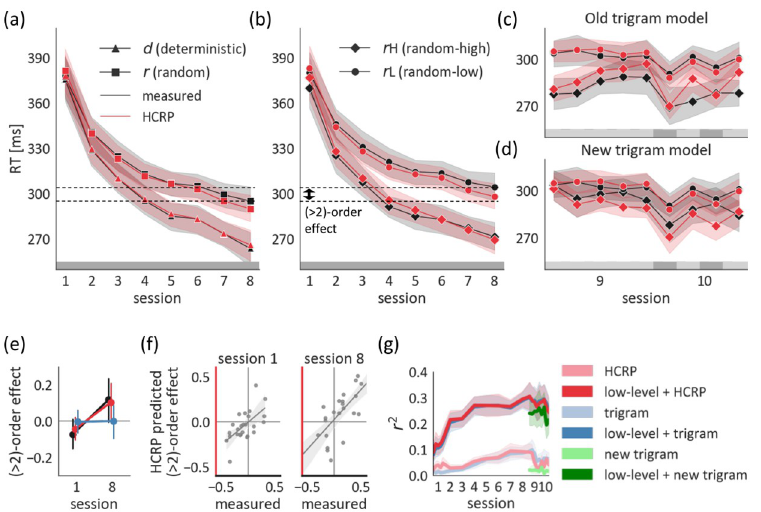
Fig 7. Calibration of the HCRP model. (a) RTs predicted by our HCRP model are shown against measured RTs for d versus r trials on held-out test data. (b) Same as (a) for r H versus r L trials. The two dashed lines mark the mean RTs for d and r H trials in session 8. The RT advantage of d over r H by session 8 marks ( > 2)-order sequence learning. (c-d) r H versus r L trials are labelled according to the old trigram model (i.e. old sequence) or the new trigram model (i.e. new sequence). The grey band on the bottom shows the sequence that participants practiced: the old sequence in sessions 1–8 (dark grey), the new sequence in session 9 (light grey) and alternating the two sequences in session 10. (e) ( > 2)- order sequence learning, quantified as the standardized RT difference between r H and d trials, shown for measured and predicted RTs. In session 1, r H trials are more expected because they reoccur sooner on average. By session 8, d trials are more expected because they are more predictable, given a > 2 context. This was predicted by the HCRP but not the trigram model. (f) Correlation of the measured and predicted ( > 2)-order effect in session 1 and session 8. (g) Average predictive performance of the HCRP and the trigram models. (a-g) The error bands and bars represent the 95%CI.